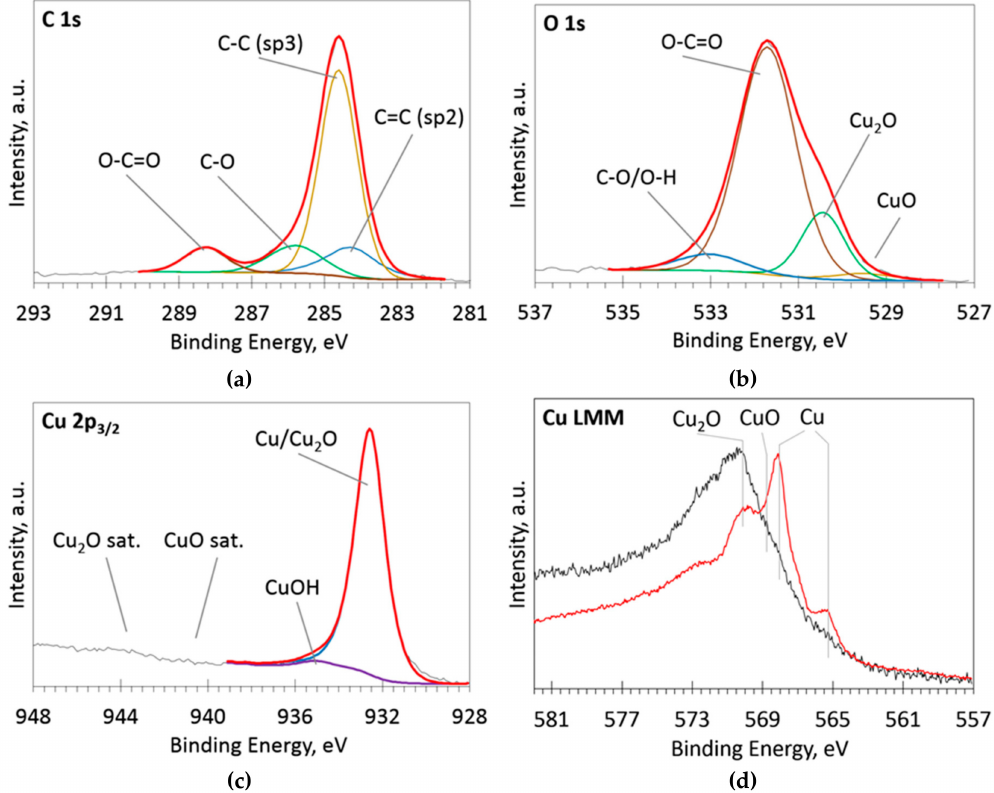
Figure 3. Deconvoluted high resolution C1s ( a ), O1s ( b ), Cu2p ( c ), Cu LMM ( d ) X-ray photoelectron spectra (XPS) spectra of the sample Cu09. Black thin line–acquired data, colored thick lines—fitted peaks, red thick